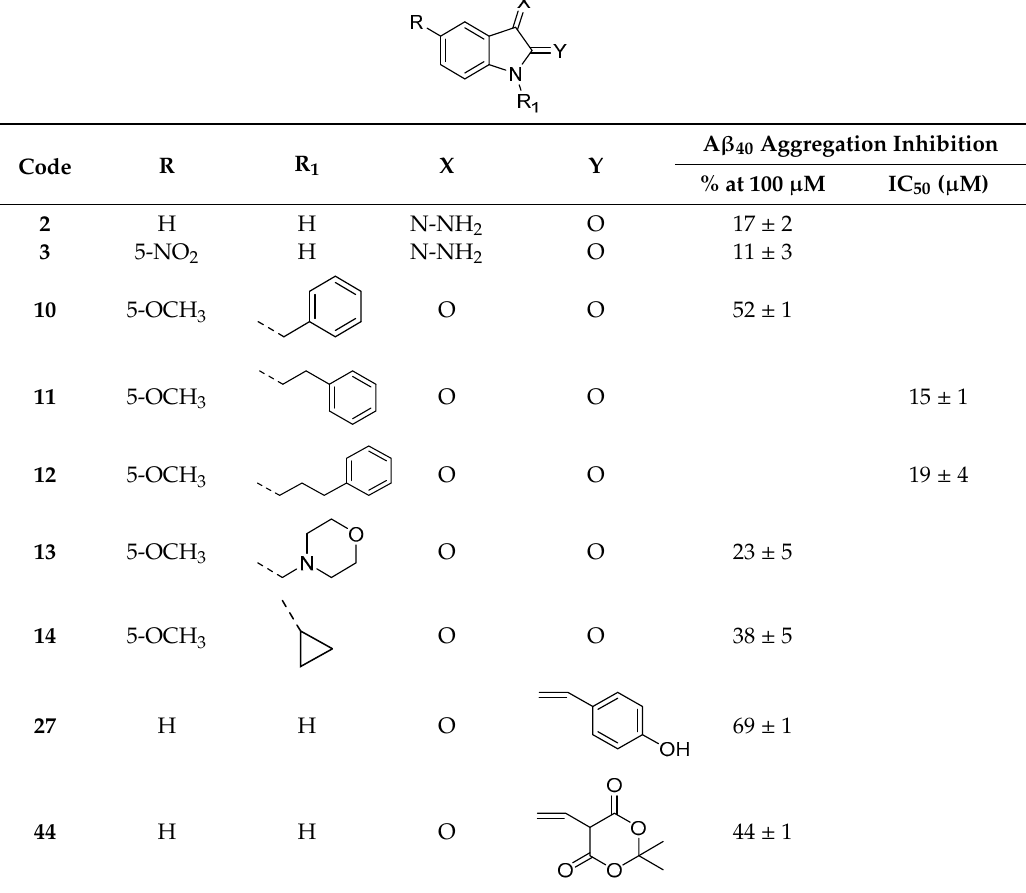
Table 2. Inhibition data of new isatin derivatives 2 , 3 , 10 – 14 , 27 and 44 .